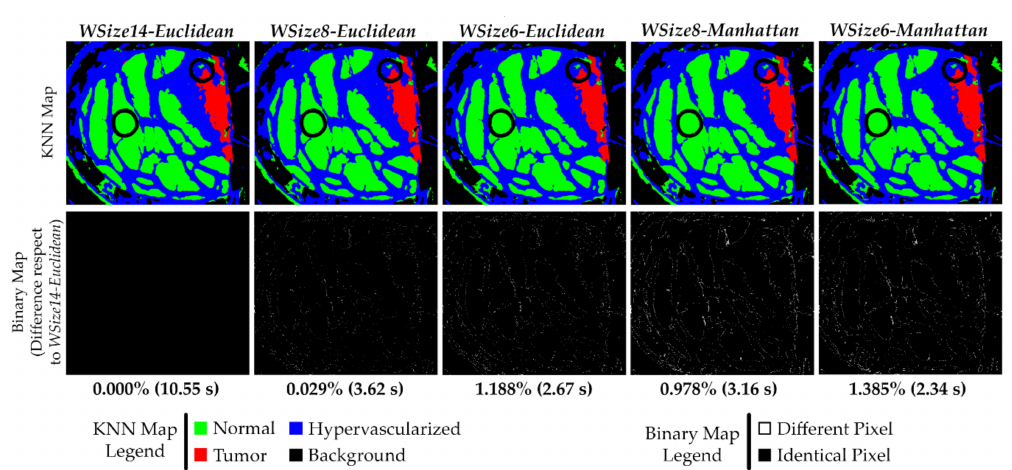
Figure 12. Results comparison of the KNN filtered maps from the P2C1 image using both the Manhattan and Euclidean distances. The first row shows the filtered classification maps generated using different window sizes and distance metrics. The second row presents the binary maps where the pixel differences between the current generated map and the reference one ( WSize14-Euclidean ) are shown. In addition, the percentage of differences and the execution time results are detailed.